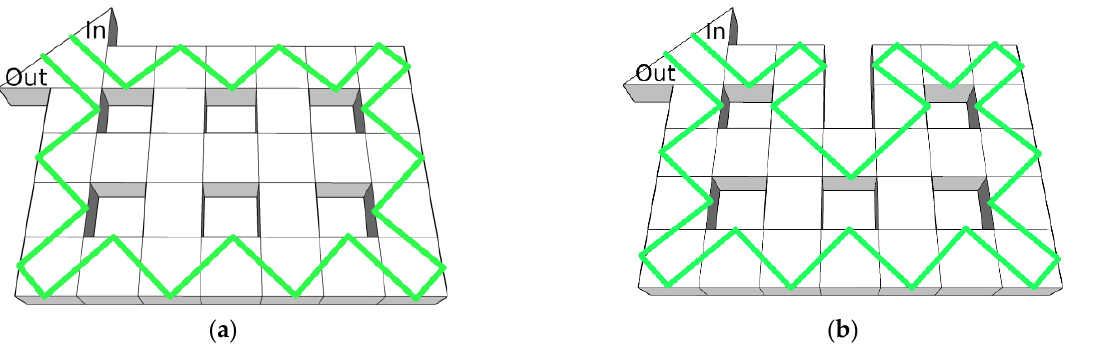
Figure 1. ( a ) The prism resonator made of quartz glass with a refractive index of 1.43. ( b ) A model of the tiling photonic topological insulator (TPhTI) composed of 28 prism resonators. ( c ) The TPhTI, composed of seven prism resonators.